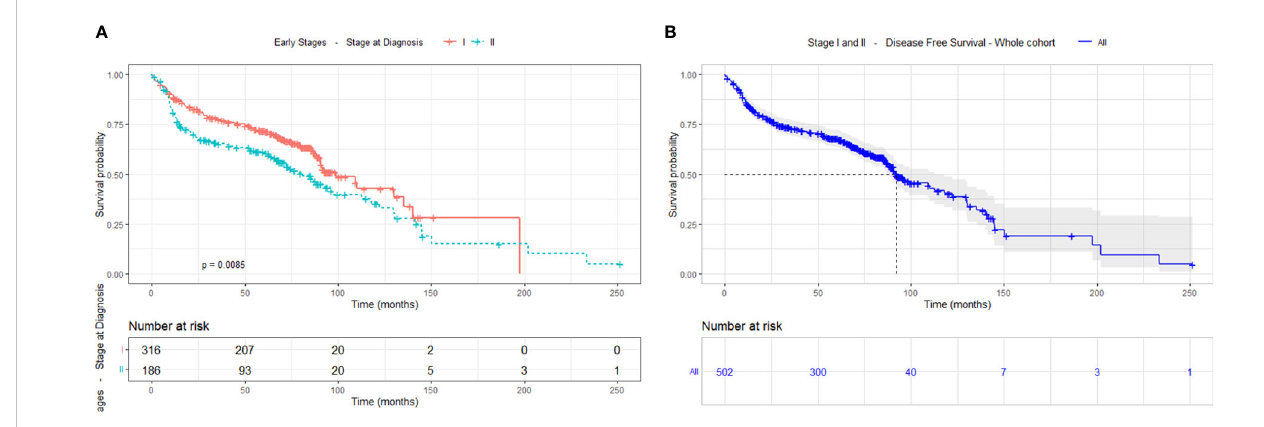
FIGURE 3 Disease-free survival, (A) by cancer stage (I-II) and (B) of the whole